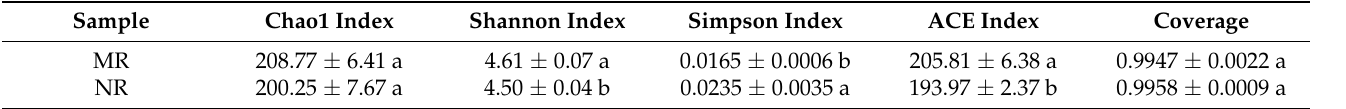
Table 1. Soil bacterial diversity